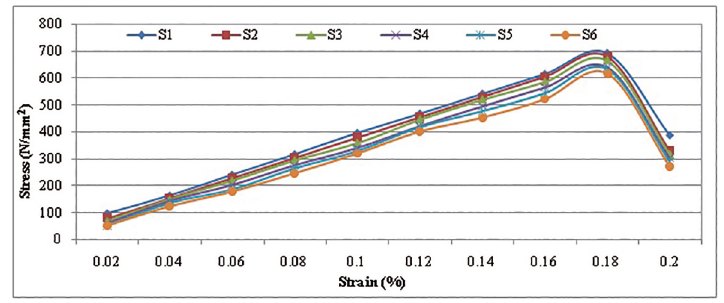
Figure 10: Stress-strain curves for the composite samples subjected to flexural loading